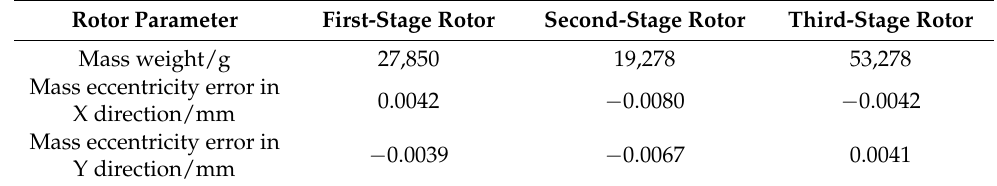
Table 3. Mass characteristics and centroid parameter errors of rotary parts